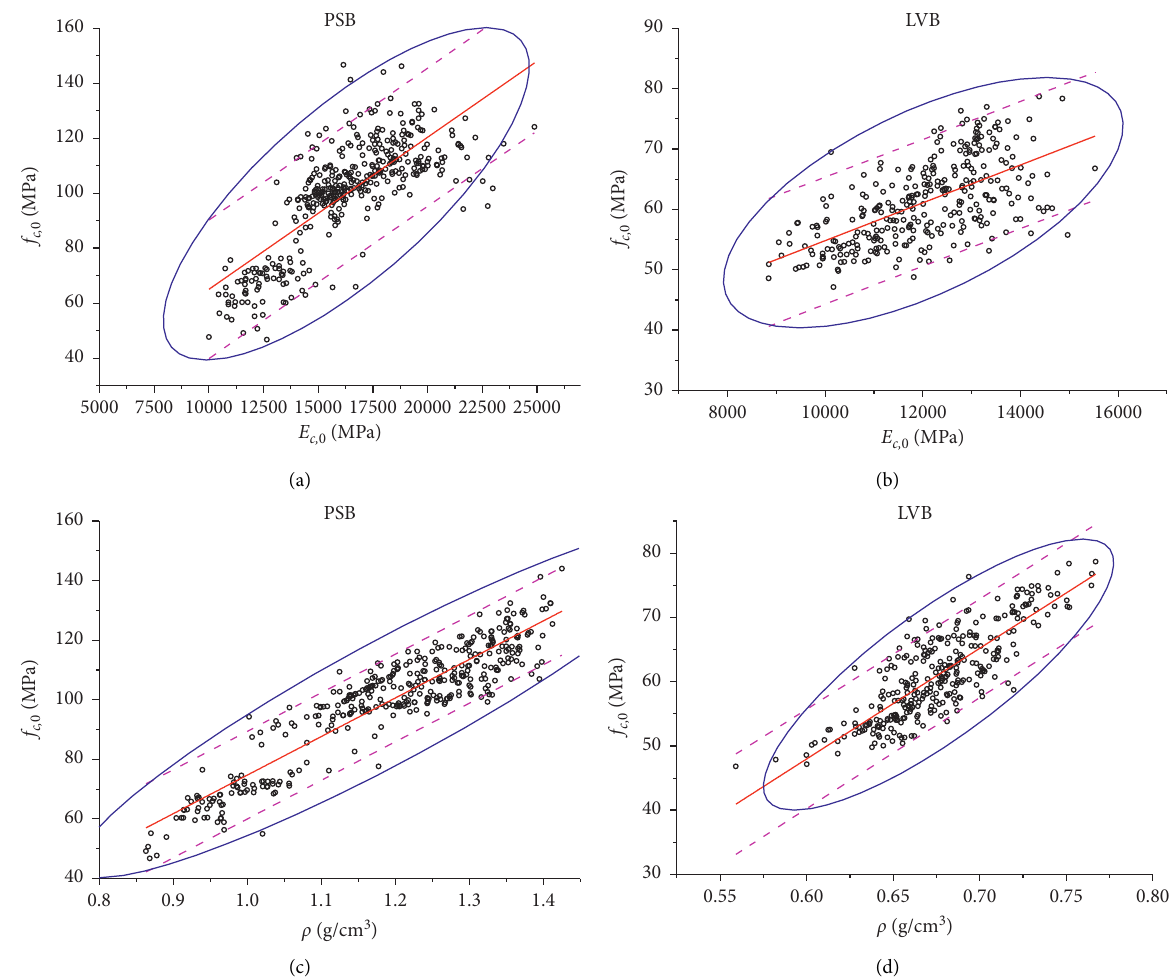
c ,0 against E c , 0 for PSB (a); f c , 0 against E c , 0 for LVB (b); f c ,0 against ρ